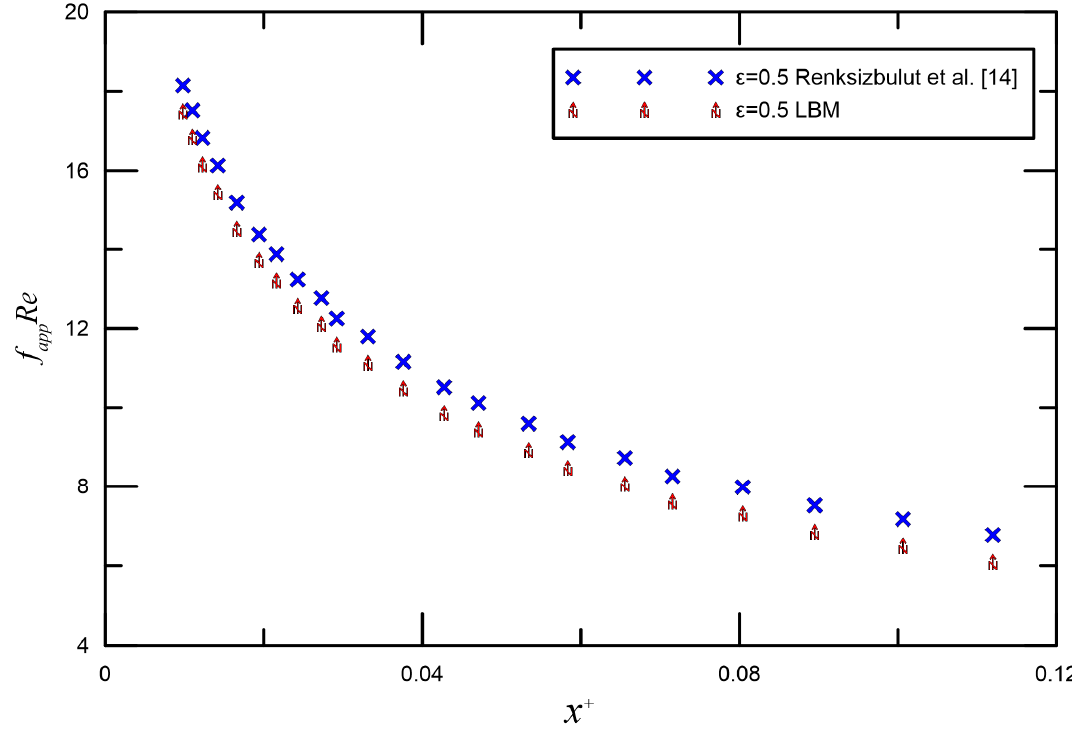
Figure 4. Comparison of f app Re for the numerical data by Renksizbulut et al. [14] for ε = 0.5 in the continnum flow regime.